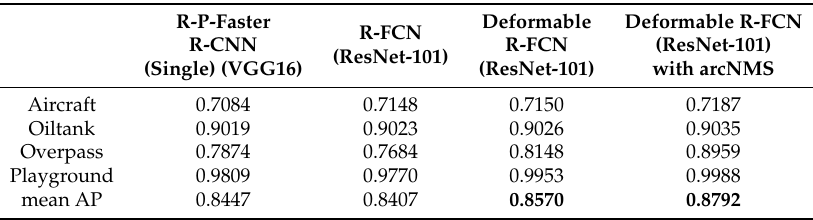
Table 3. The AP (Average Precision) values of the object detection methods on the RSOD (Remote Sensing Object Detection)